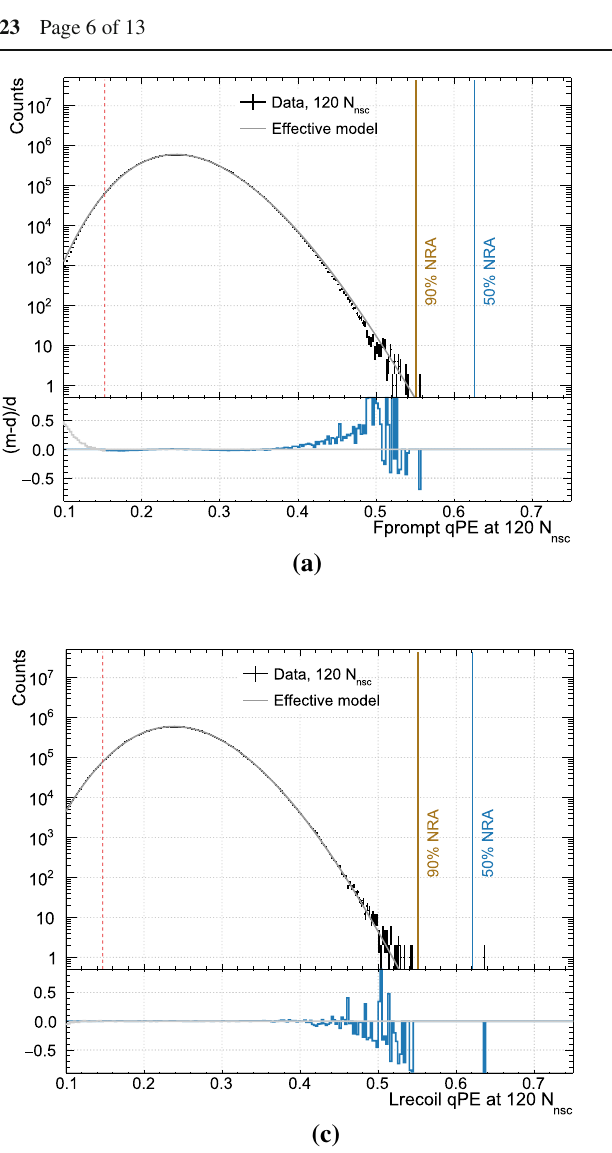
Fig. 2 The PP distributions for events at 120 N nsc (approximately 19.65keV ee to19.82keV ee )areshowntogetherwiththeeffectivemodel fits. The bin width is 0.0025 and there are 2 . 8 · 10 7 events in each his- togram. The vertical dashed red line marks the F prompt value above